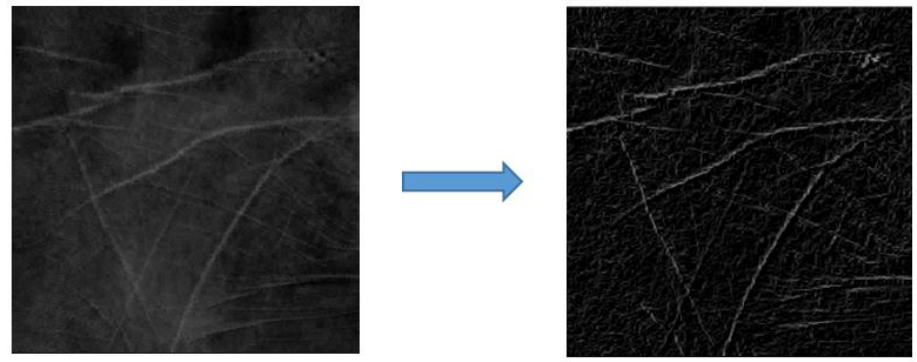
Figure 11. Four 3 × 3 Sobel operators in different orientations.